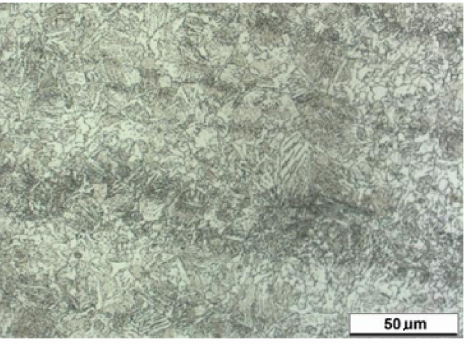
Figure 7. Microstructure of the welded specimen after relief annealing (500 × magnification), bainite and sorbite